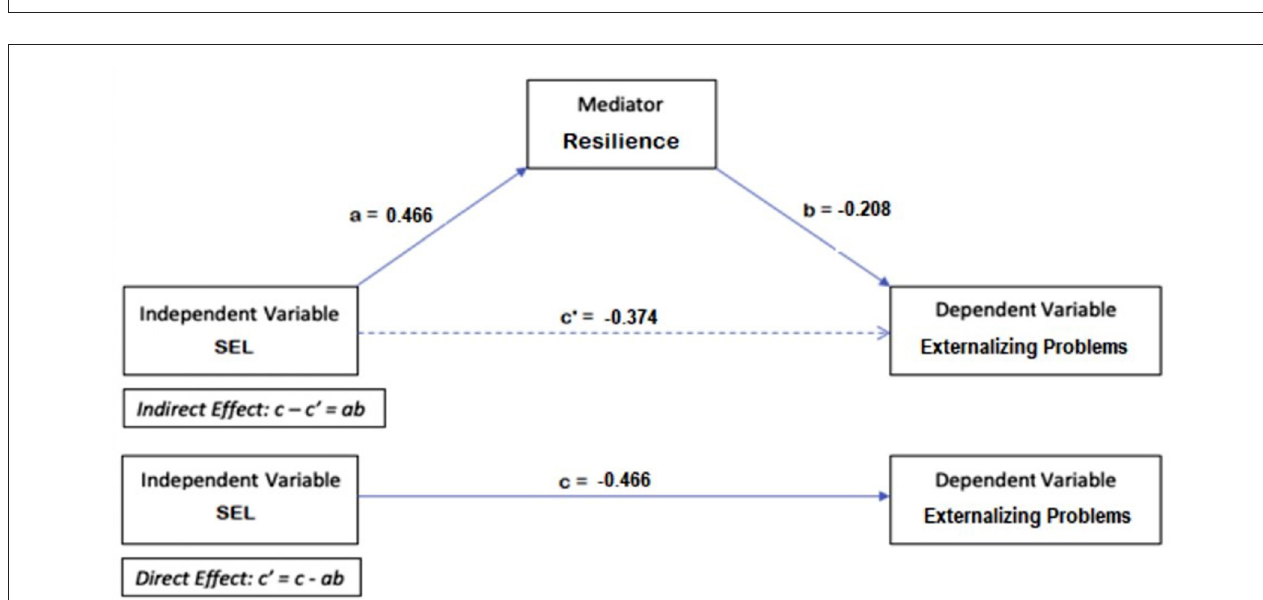
FIGURE 1 | Mediation model for internalizing problems.